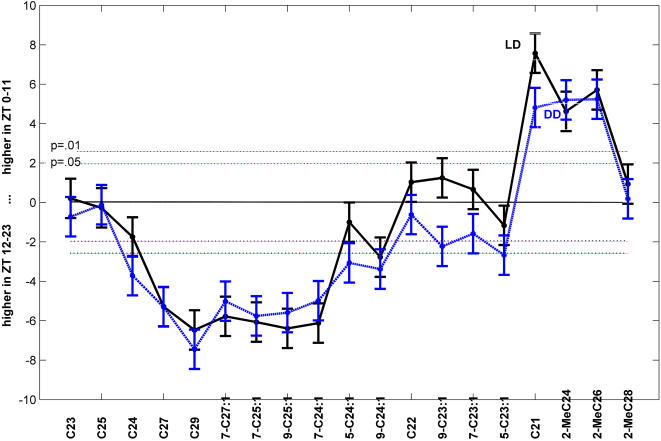
Significance of differences between subjective day and subjective night FA-normalized mean compound abundance in LD (solid line) and DD (dashed line).Y axis gives Student t test value for comparison (df = 275 in LD and 346 in DD for each compound). Error bars, ±1 s.e. Critical values of t for a two-sided test are given for p = .05 and .01. Compounds ordered by cluster membership – see Figure 4 (low abundance compounds are omitted). C21 and shorter chain methyl-alkanes have highly significantly higher mean in day than at night, while long chain n-alkanes (cluster 1) and clusters 2 and 3 (longer chain monoenes) highly significantly higher mean at night. For most compounds, mean day-night difference is not effected by presence of light in day (LD) or its absence (DD). However, cluster 4 members (tricosenes and C21) do show a significant increase in the day-night mean difference in LD.